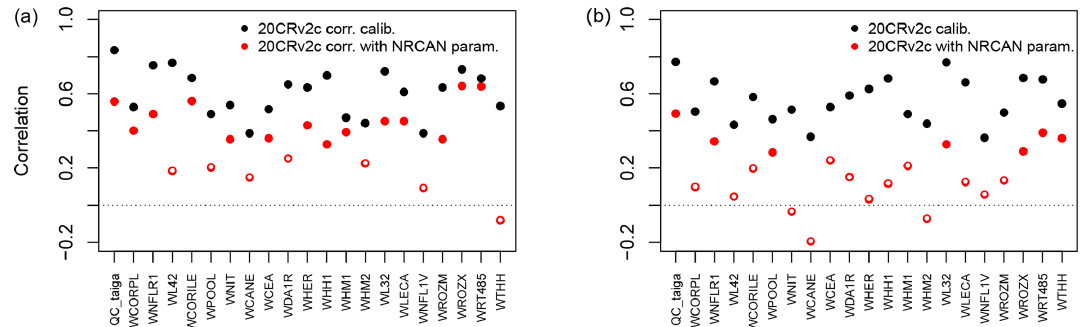
Figure 6. Pearson correlation coefficients between tree-growth observations and simulations at the Eastern Canadian taiga sites (Fig. 1a) with MAIDEN using the 20CRv2c corr. (2 ◦ ) (a) or 20CRv2c (2 ◦ ) (b) climatic dataset for the 1950–2000 period with parameters calibrated using NRCAN (5arcmin) (with NRCAN param.) climatic inputs and with parameters calibrated using 20CRv2c corr. (2 ◦ ) (a) or 20CRv2c